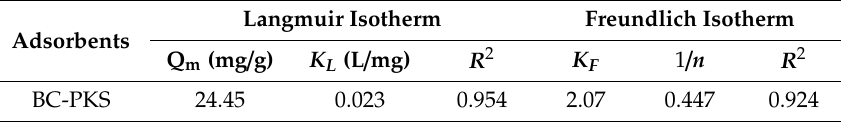
Figure 2. CV adsorption to BC-PKS as a function of equilibrium concentration of CV with the Langmuir and Freundlich isotherm model fits (initial concentration: 50–500 mg/L; volume: 30 mL; adsorbent dosage: 0.5 g; reaction time: 24 h; temperature: ° C). Table 2. Langmuir and Freundlich constants for CV on BC-PKS.